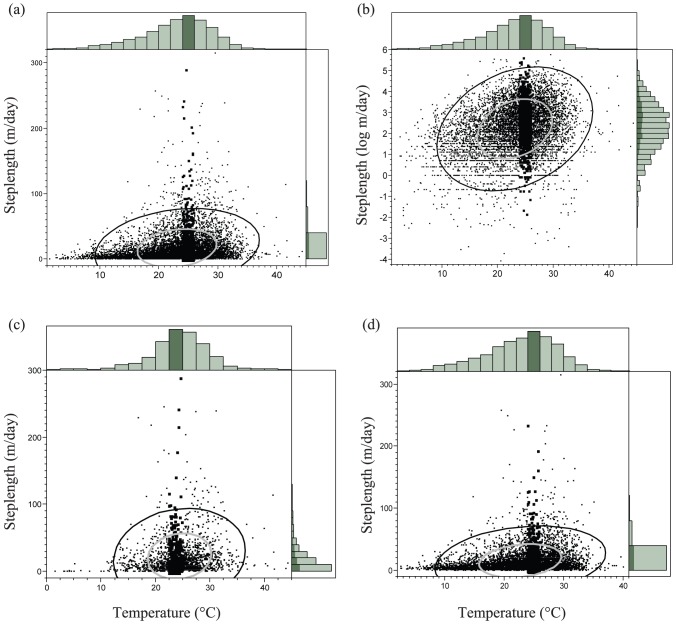
Thermal Optima.Scatter plot of daily distances traveled by eastern box turtles (steplengths; y-axes) by ground temperature (Tg in °C; x-axes). All 2007–10 steplengths (in meters per day) by ground temperature (a.) and the log-transformed steplength by ground temperature (b.). Pre-harvest (2007–08) steplength in meters per day by ground temperature (c.) and post-harvest (2009–10; d.). Plots show 95% (black ellipse) and 50% (grey ellipse) density ellipses around points and histogram densities along plot boarders. Darkened areas represent the peak of activity temperatures (22–26°C; thermal optimum) in these data.